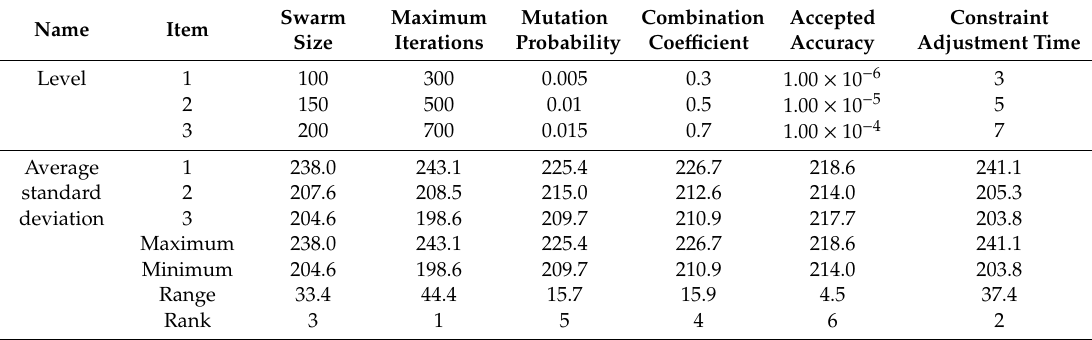
Table 11. Sensitivity analysis results of the HSCA method with different parameters in summer.